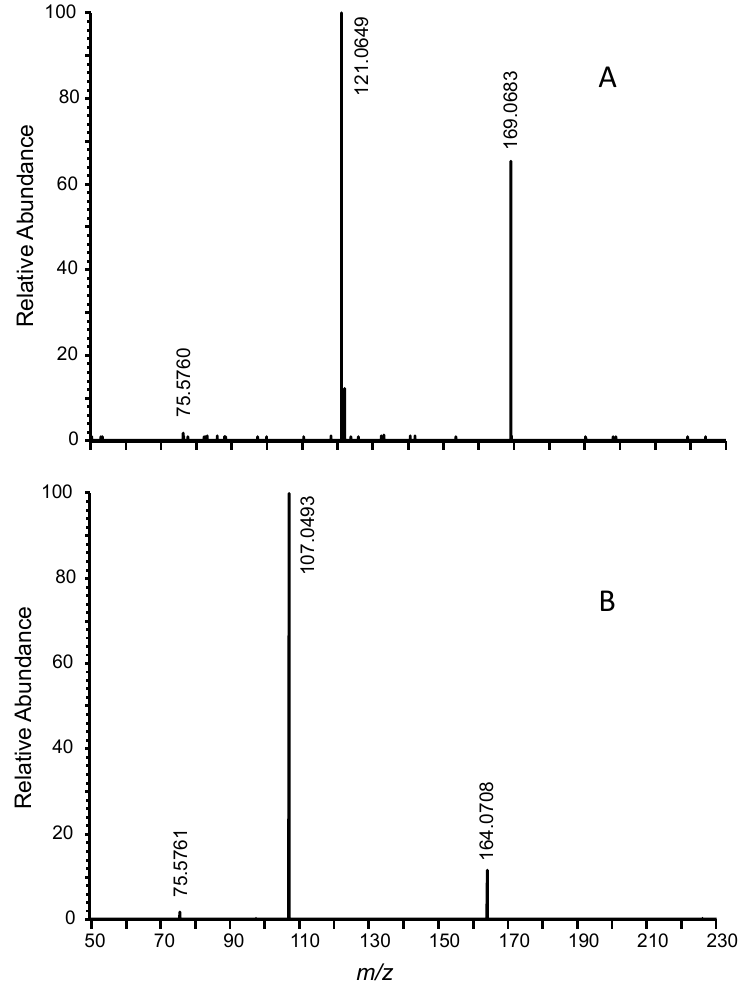
Figure 3. Positive ESI spectra obtained with an NCE 20 eV for ( A ) methiocarb and ( B ) ethiofencarb.